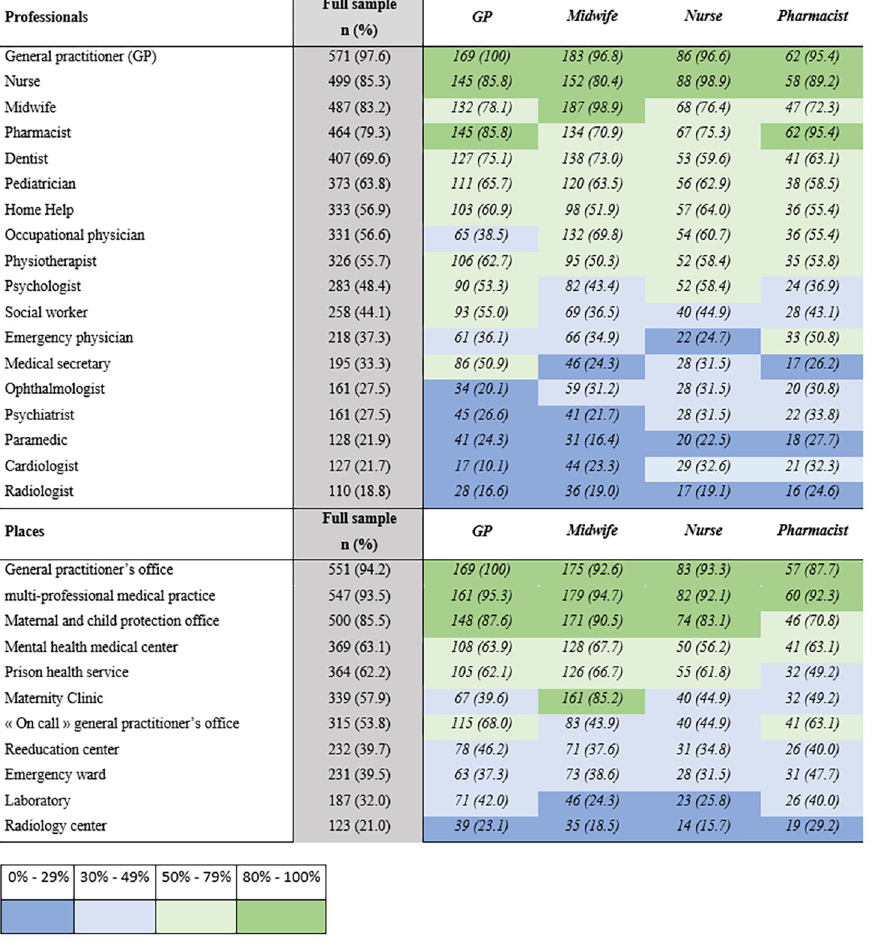
Fig 2. Professionals and places associated with primary